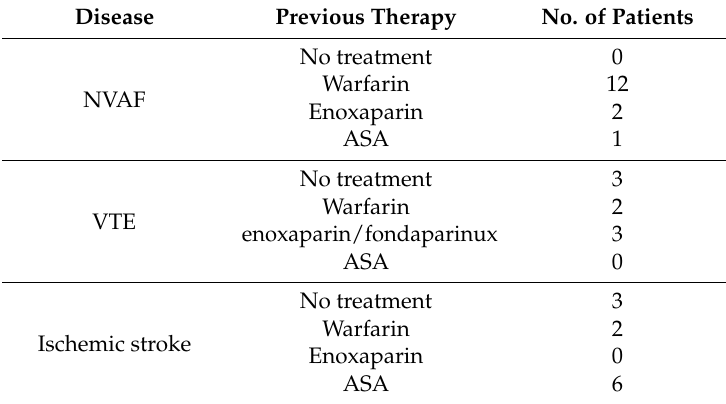
Table 1. Previously prescribed therapies in patients classified according to the underlying